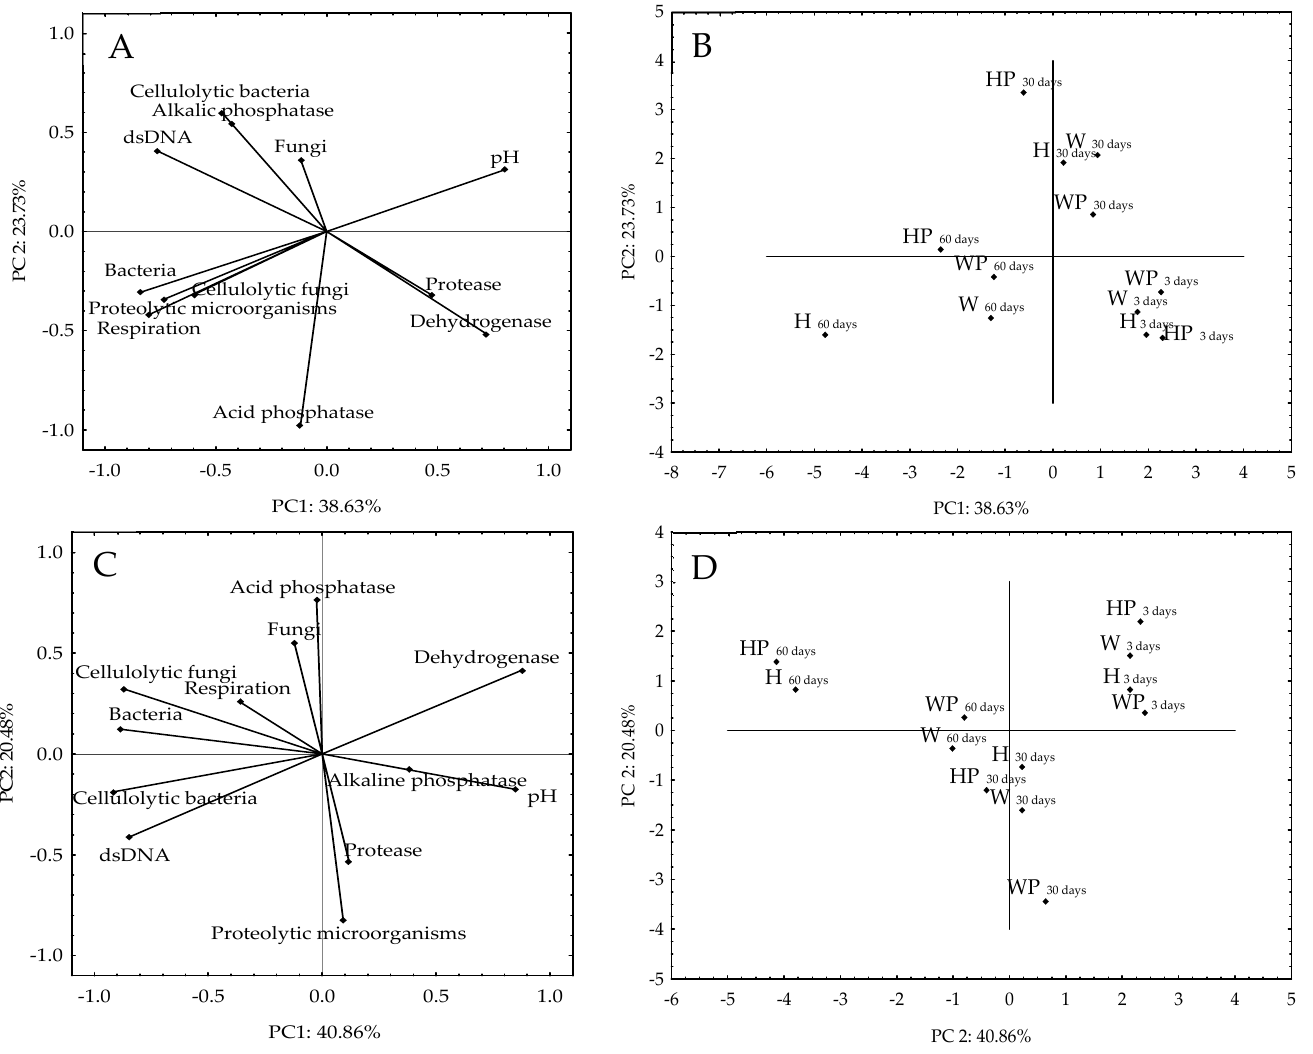
Figure 4. The loading plot ( A , C ) and the score plot ( B , D ) showing the number of selected groups of microorganisms and respiratory/enzymatic activity in Cambisol I ( A , B ) and Chernozem ( C , D ) in different experimental variants.